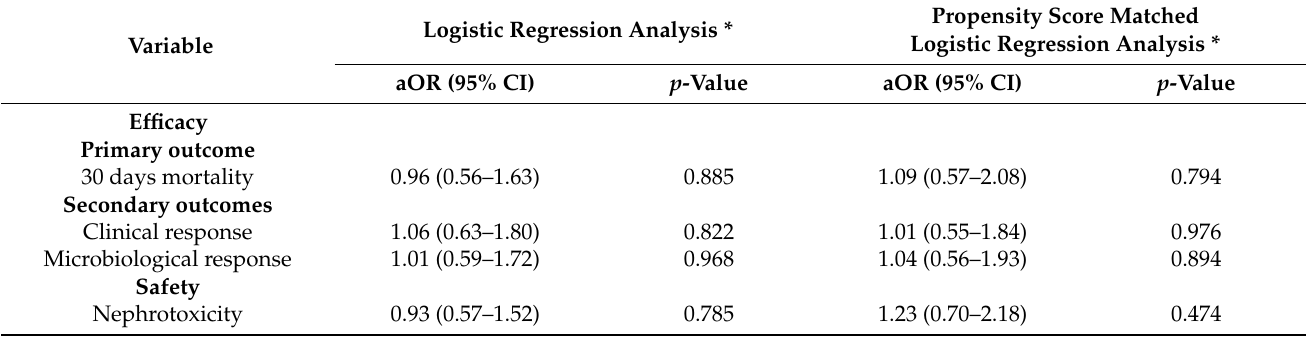
Table 3. Logistic regression analysis of outcomes for critically ill patients receiving colistin monotherapy compared with colistin vancomycin combination